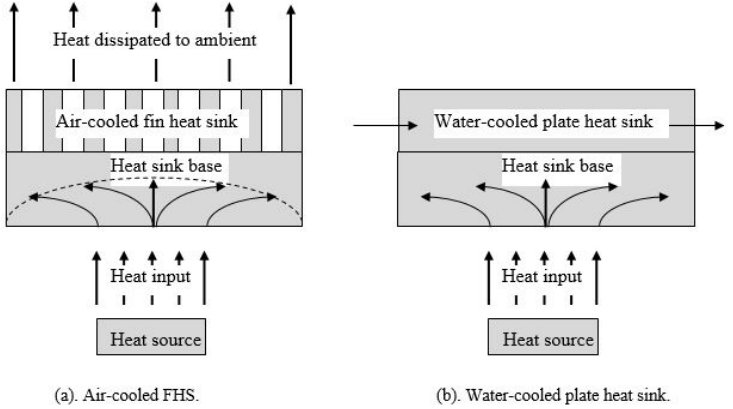
Figure 1. Thermal cooling with an air-cooled FHS (fin heat sinks) and water-cooled plate heat sink. ( a ) Air-cooled FHS; ( b ) Water-cooled plate heat sink.